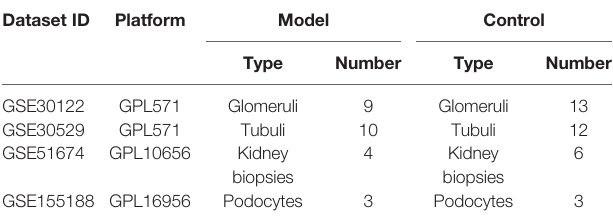
TABLE 1 | The microarray dataset information.